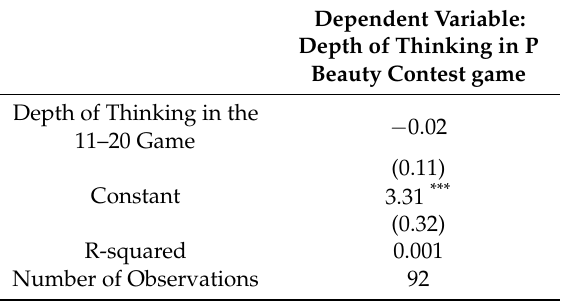
Table A3. The Relationship between the Depth of Thinking in the P Beauty Contest Game and the 11–20